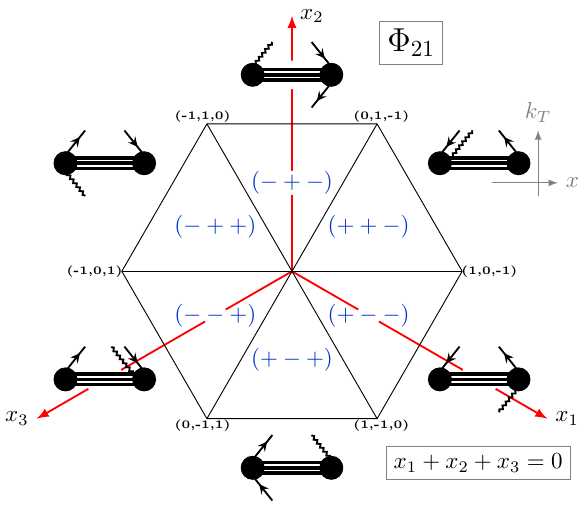
Figure 2 . Support of the TMD correlator Φ 21 in the space x 1 , x 2 , x 3 . The momentum fractions are constrained to x + x + x = 0 and x [ − 1 , 1] . Each sector of the hexagon has independent 1 2 3 i ∈ interpretation as a process with radiation/absorption of partons with positive collinear momentum fractions. The difference between transverse momenta of quark and anti-quark-gluon pair is k The interpretation process for each sector is shown by diagrams, where horizontal/vertical axis is for collinear/transverse momentum. For the correlator Φ the picture is analogous, but with the 12 transverse momentum of the gluon